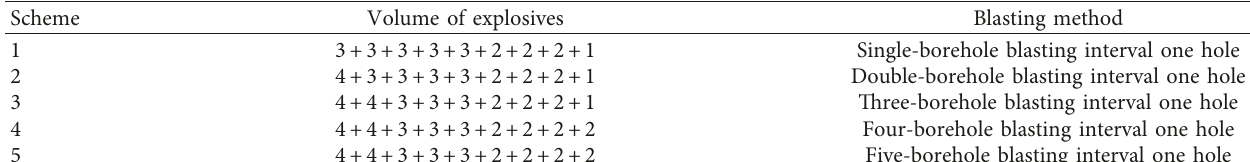
Table 4: Experimental schemes for the volume of explosives.